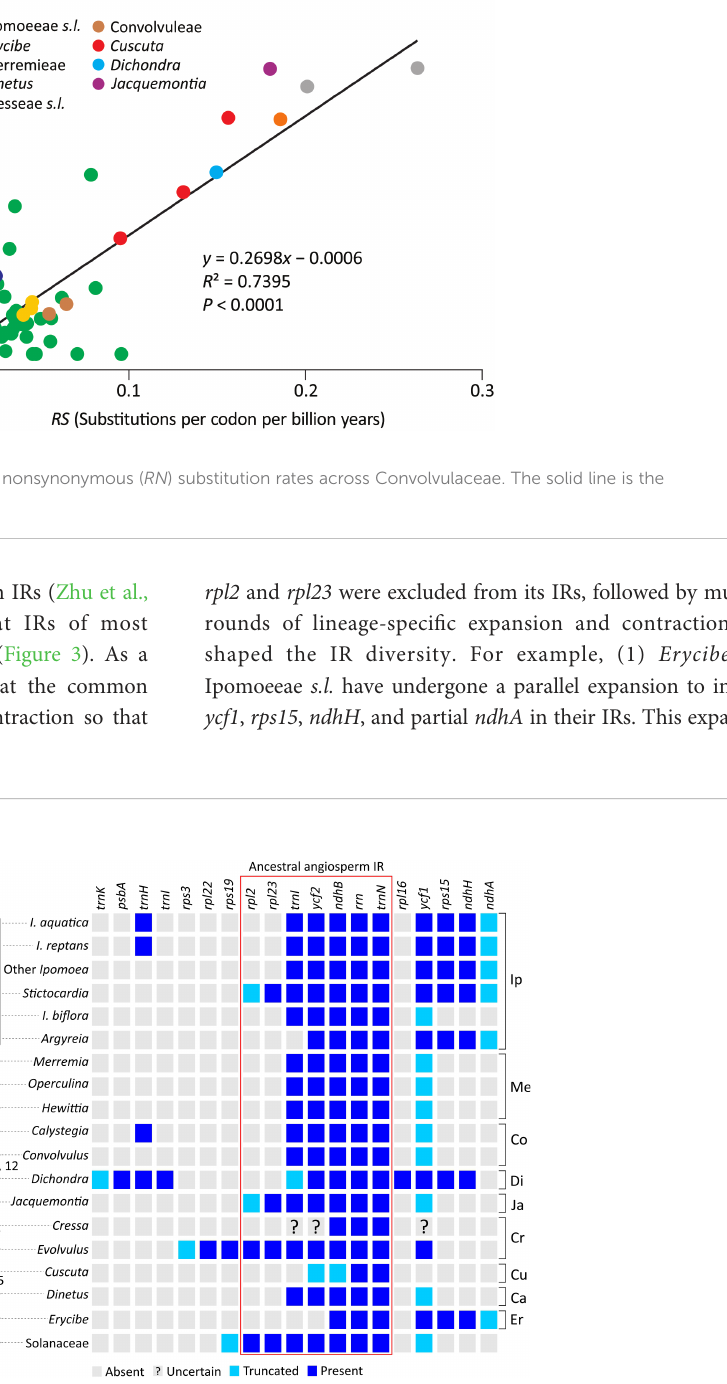
FIGURE 3 Evolution of plastomic rearrangements across Convolvulaceae. The right panel depicts presences/absences of genes in IRs. A “ ? ” mark indicates that the gene state is uncertain due to poor sequence quality. Numerals on branches of the left panel tree denote speci fi c rearrangements outside IRs. 1, loss of infA ; 2, loss of the rpl2 intron; 3, inversion of the atpI − atpB region; 4, duplication of psbT ; 5, loss of rpl23 ; 6, loss of the rps16 intron; 7, loss of the rpoC1 intron; 8, integration of PTMTs between psaA and ycf3 ; 9, inversion of the trnL − atpB region; 10, loss of rpl23 ; 11, loss of the rps16 intron; 12, loss of all introns from ycf3 ; 13, loss of rpl23 . Ip, Ipomoeeae s.l. ; Me, Merremieae; Co, Convolvuleae; Di, Dichondreae s.l. ; Ja, Jacquemontieae; Cr, Cresseae s.l. ; Cu, Cuscuteae; Ca, Cardiochlamyeae; Er, Erycibeae.